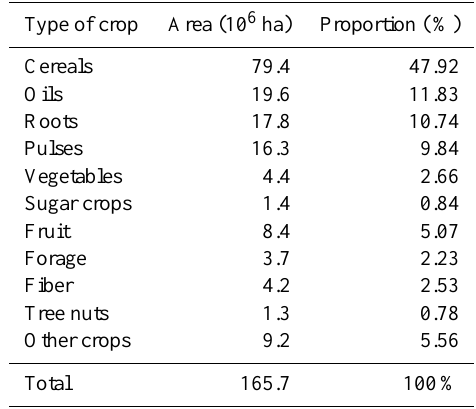
Table 1. Areal proportion of crop groups cultivated in Africa for the year 2000, adapted from Monfreda et al.